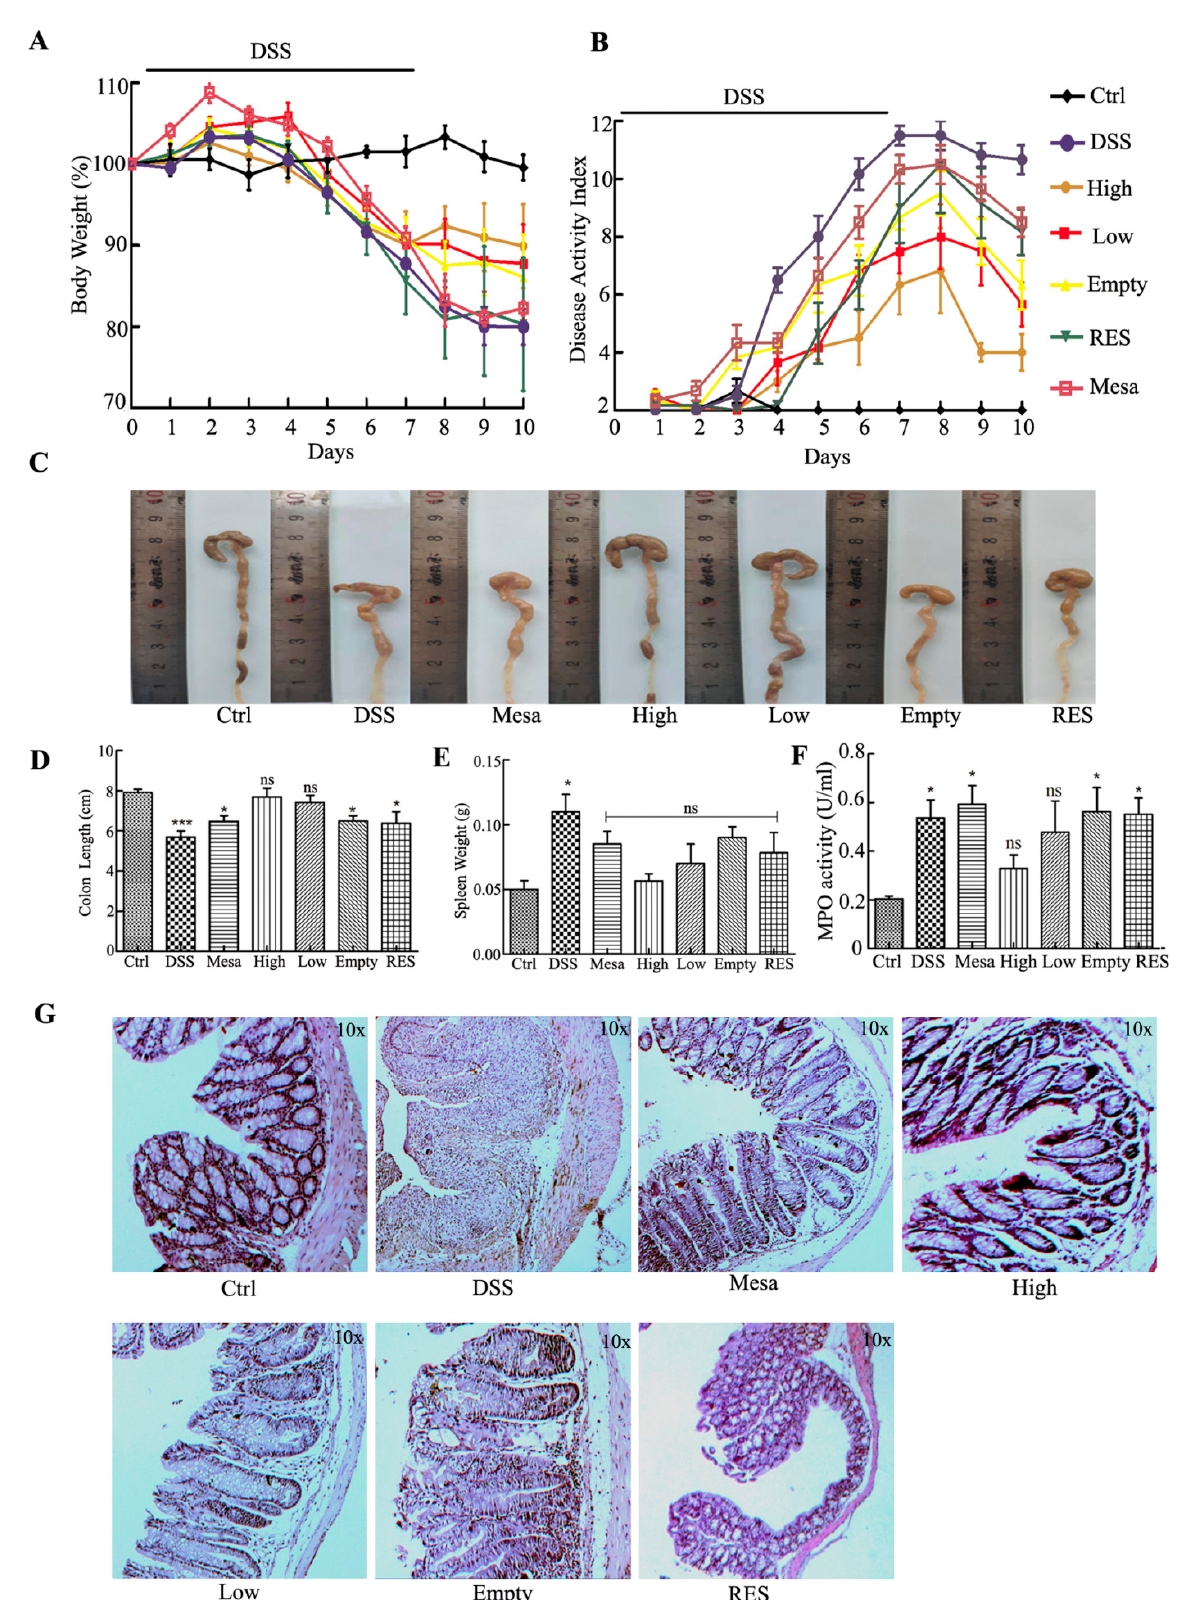
Figure 9. ( A ) Mice body weight over time, ( B ) disease activity index (DAI), ( C ) colon morphology from different groups of mice, ( D ) colon length, ( E ) spleen weight, ( F ) MPO activity and ( G ) DSS-treated mice fed with different preparations every day. HE staining was performed on representative colon sections after 10 days. The mice were divided into Healthy control mice group, DSS-treated mice group, Mesalazine-treated mice group, High-dose RES-PCAC-NPs-treated mice